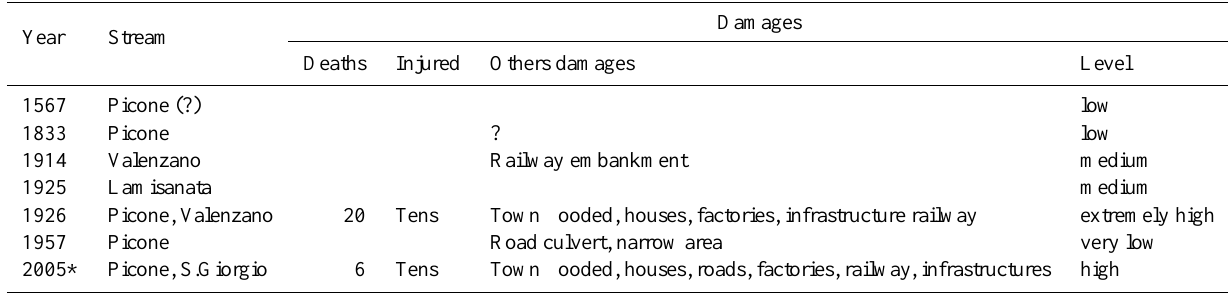
Table 1. Flood events triggering damages to embankments with bridges and/or culverts.